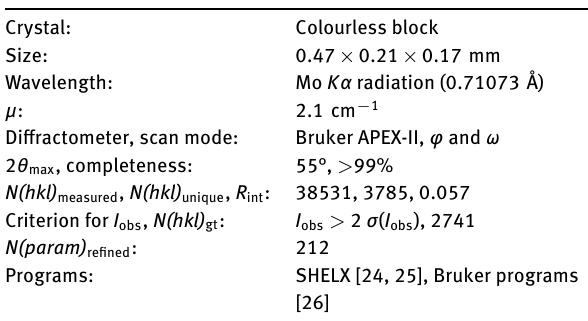
Table 1: Data collection and